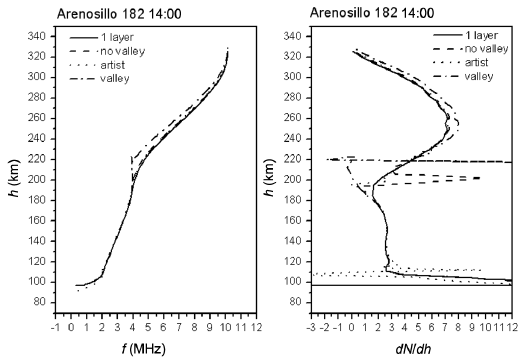
Fig. 3. Electron density profiles and first derivatives dN / dh with different inversion techniques for day 182 and hour 14 UT corresponding to El Arenosillo